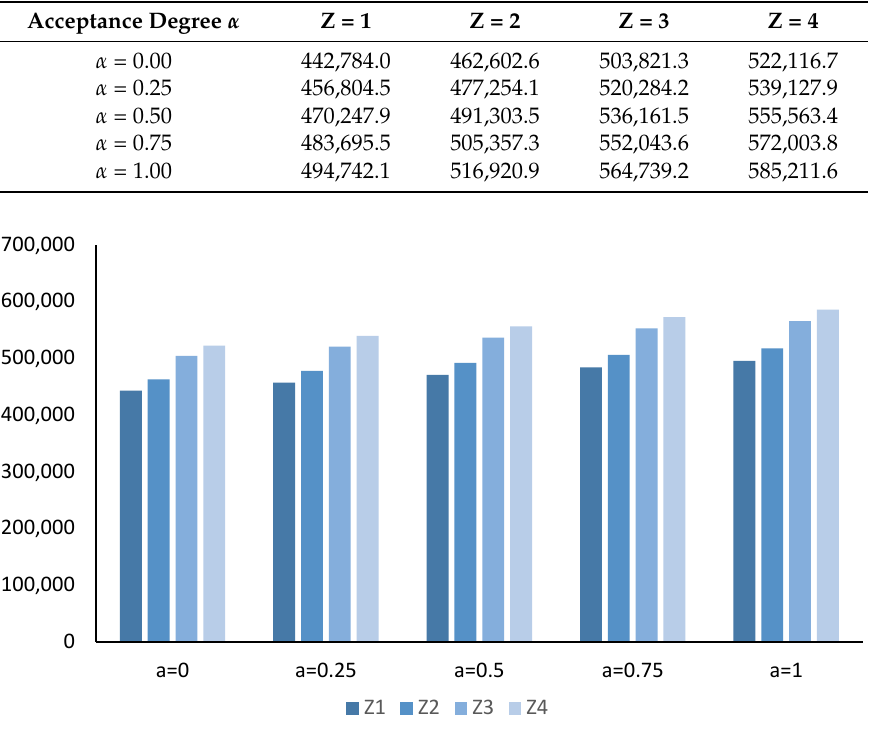
Figure 5. The average value of total profit with standard deviations.